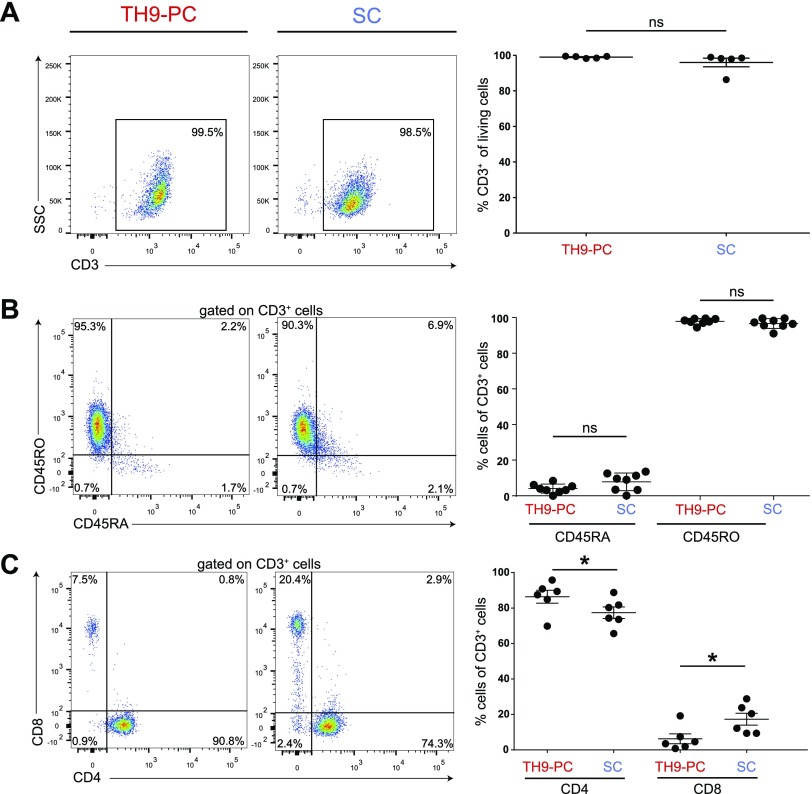
Phenotypic profile of T cells harvested from skin explant cultures after 4 wk. Representative flow cytometry dot plots (left) and quantification statistics (right; n = 5–8) of the indicated surface markers on cells cultured under Th9-PC or SC (SSC/CD3, A; CD45RO/CD45RA, B; CD8/DC4, C, IL-9/CD3, D; CCR4/CLA, E; CD69/CD103, F). Cells (D) were αCD3 and αCD28 bead–stimulated and CSC-restimulated 3 d. Quadrants were set according to isotype-matched control staining. Ns, not significant. Means ± sem are shown, and data were analyzed using Wilcoxon’s rank-sum test. *P ≤ 0.05.